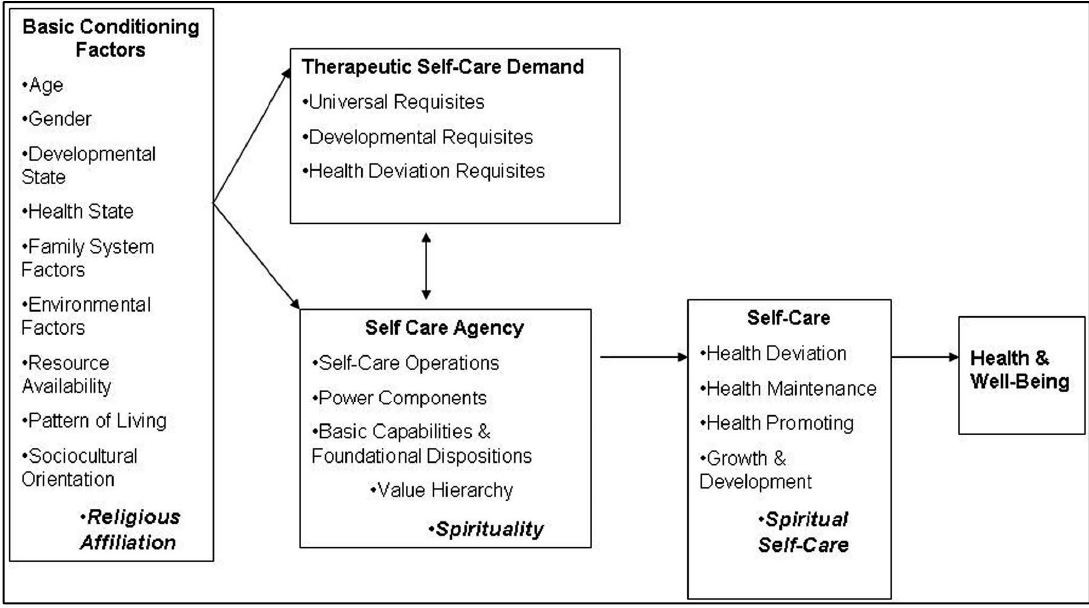
Figure 1. White’s theory of spirituality and spiritual self ‐ care (WTSSSC).